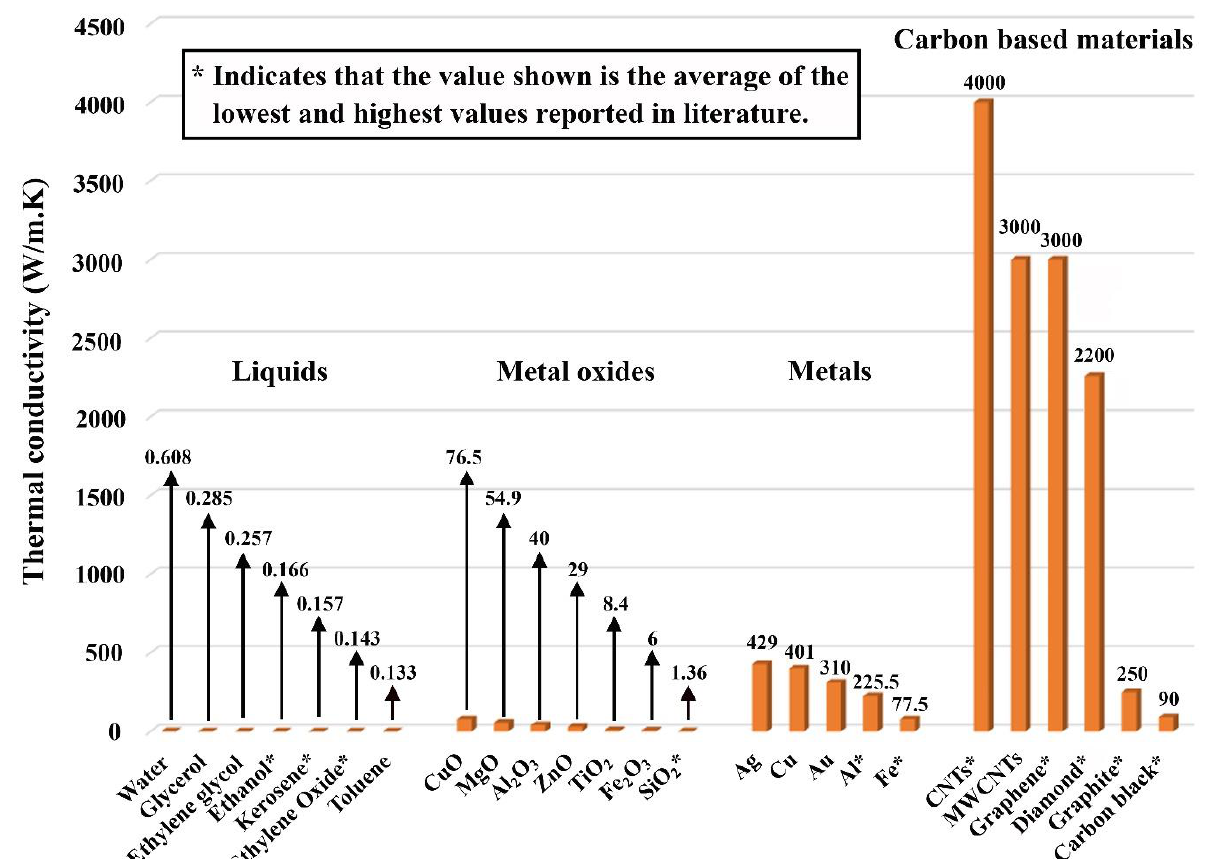
Figure 1. Thermal conductivity of commonly used particles and base fluids for fabricating nanofluids showing an order of magnitude higher in the thermal property for some of the carbon-based